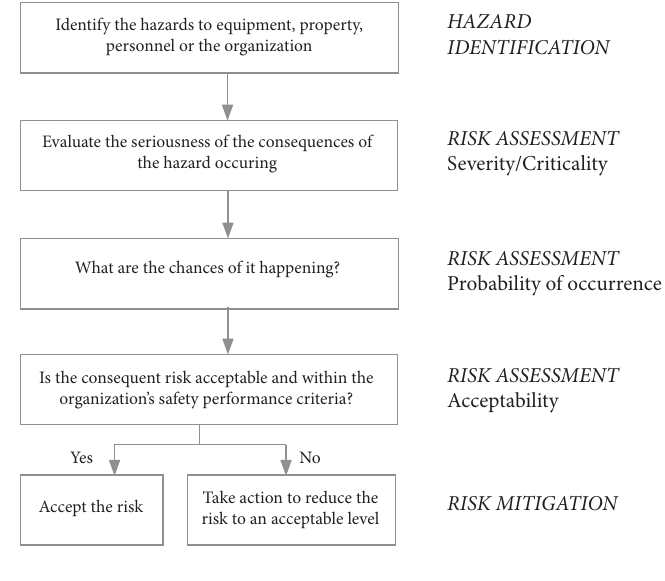
HAZARD IDENTIFICATION